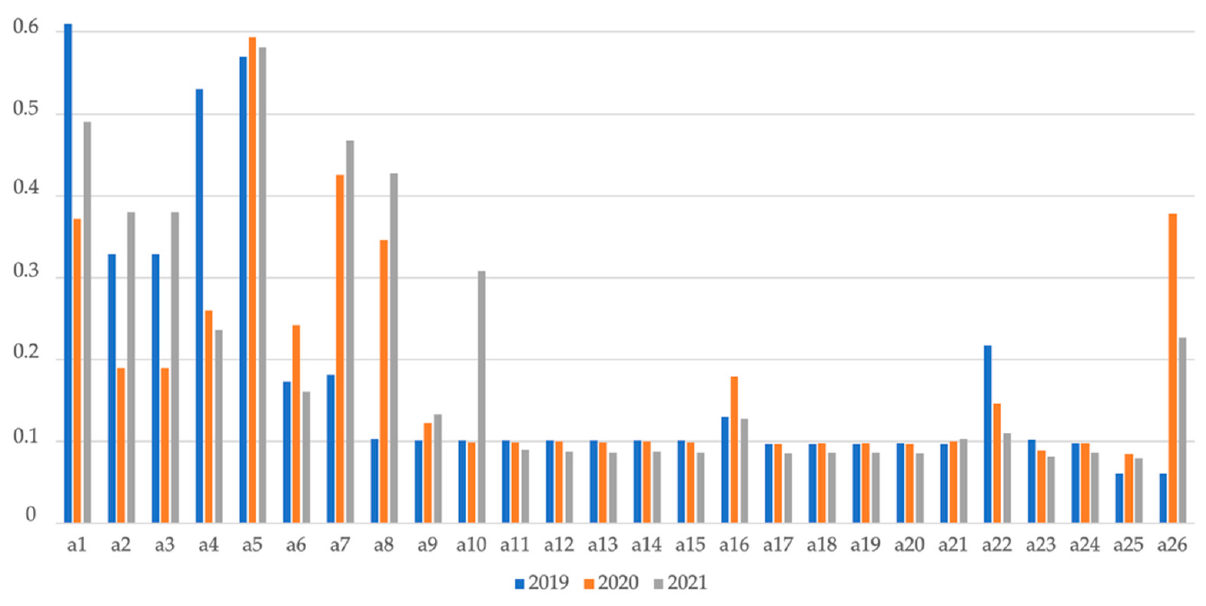
Figure 1. Ranking of alternatives with Dynamic model.